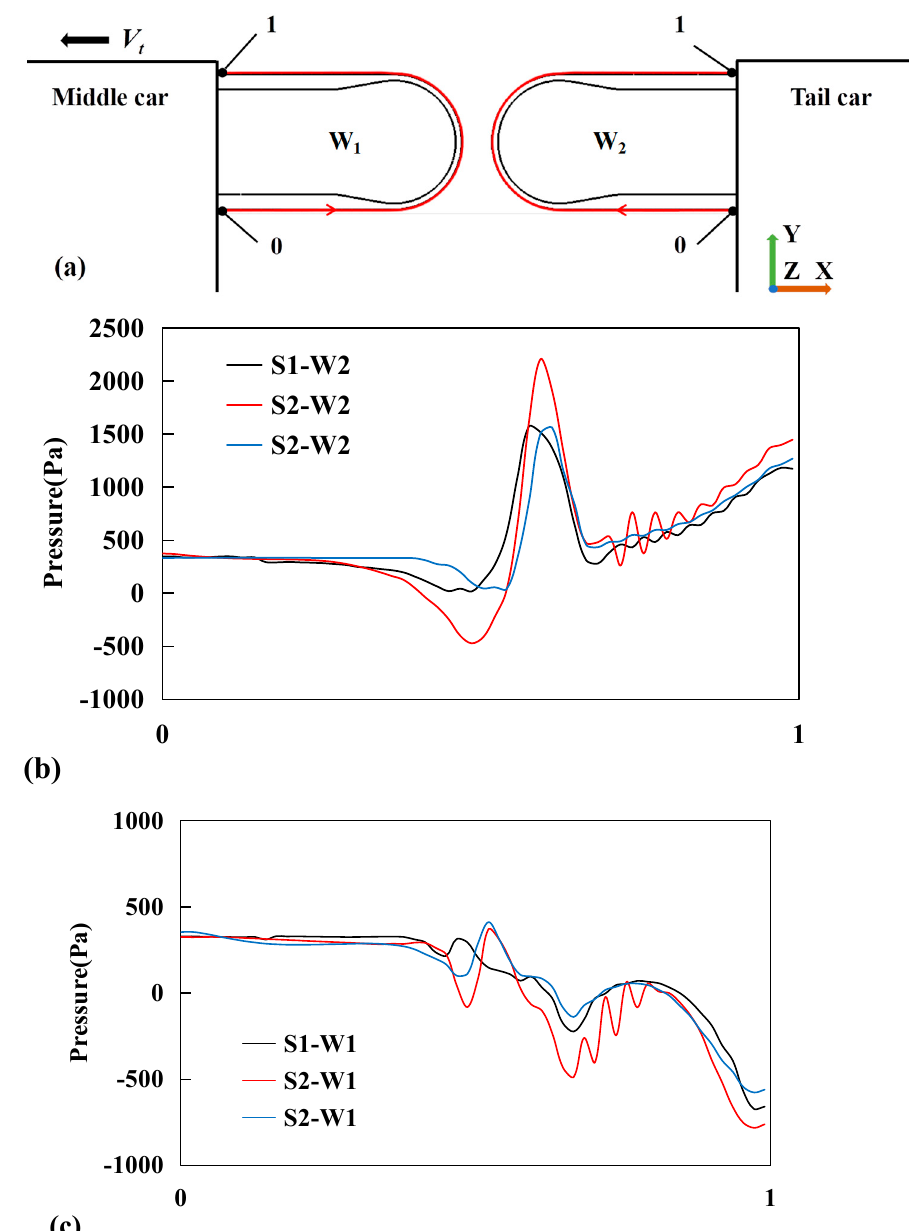
Figure 9. Pressure distribution of the windshield outer surface contour with different height sections: ( a ) schematic diagram of the windshield outer surface contour, ( b ) W2 windshield, ( c ) W1 windshield.